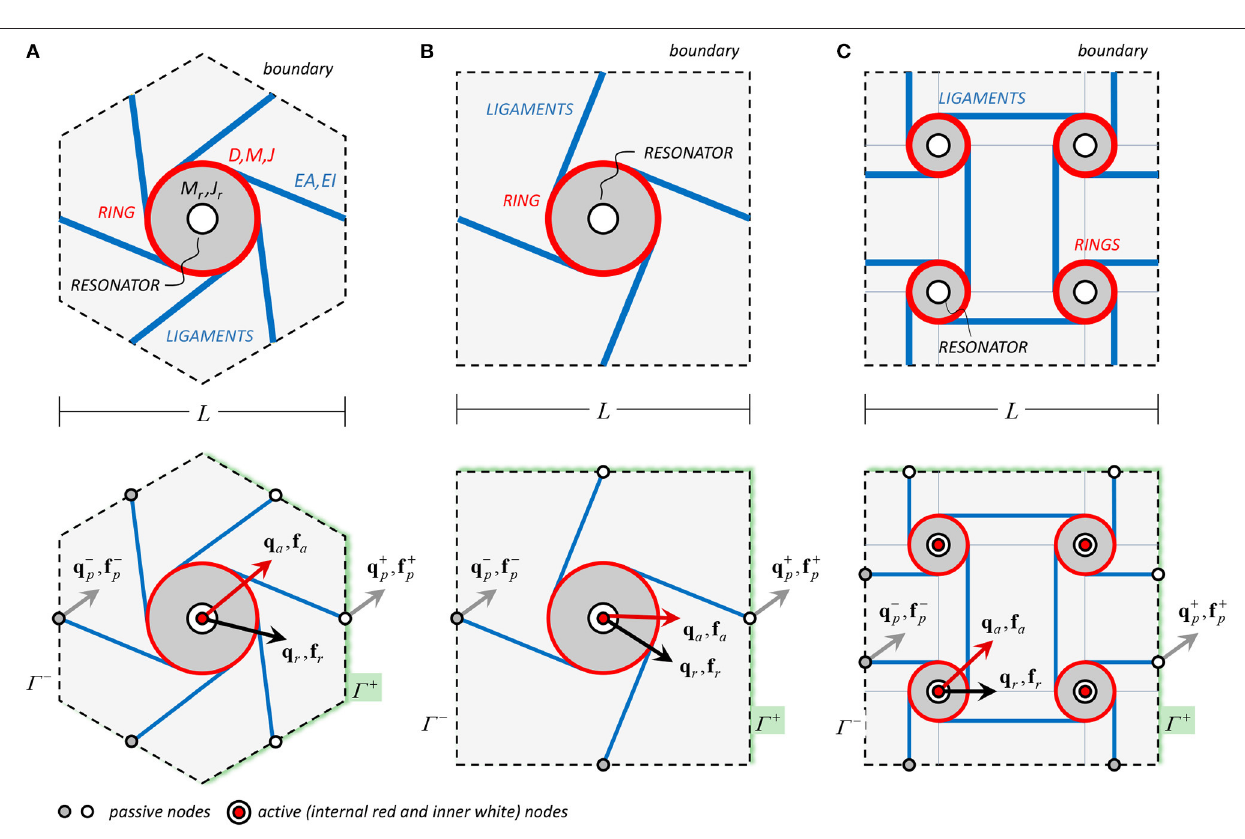
configurational nodes can conveniently be distinguished